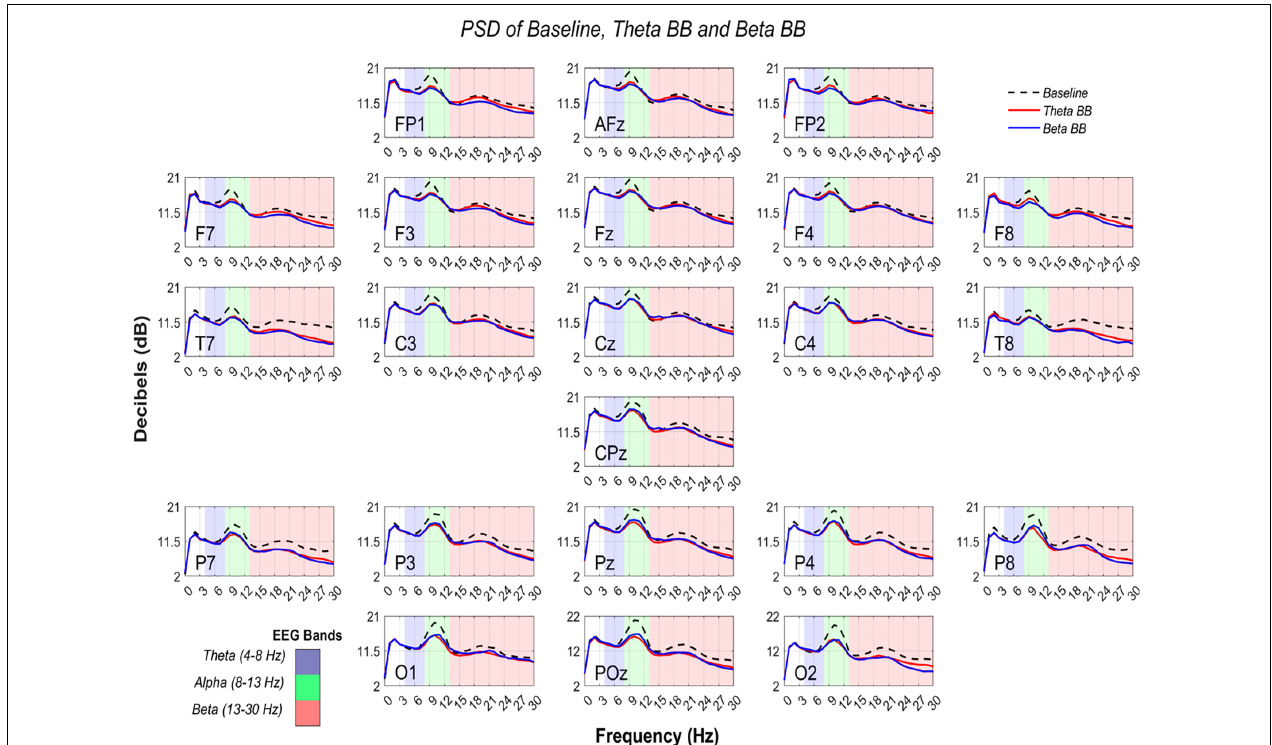
FIGURE 5 | Comparison of PSD from S1, S2, and S R . AP in dB ( Y -axis) are shown from 0 to 30 Hz ( X -axis). Black dashed line represents average AP from S R , whereas solid lines depict average AP from theta binaural beats (BB) (red) and beta BB (blue). The colored background separates theta (blue), alpha (green), and beta (red) bands.